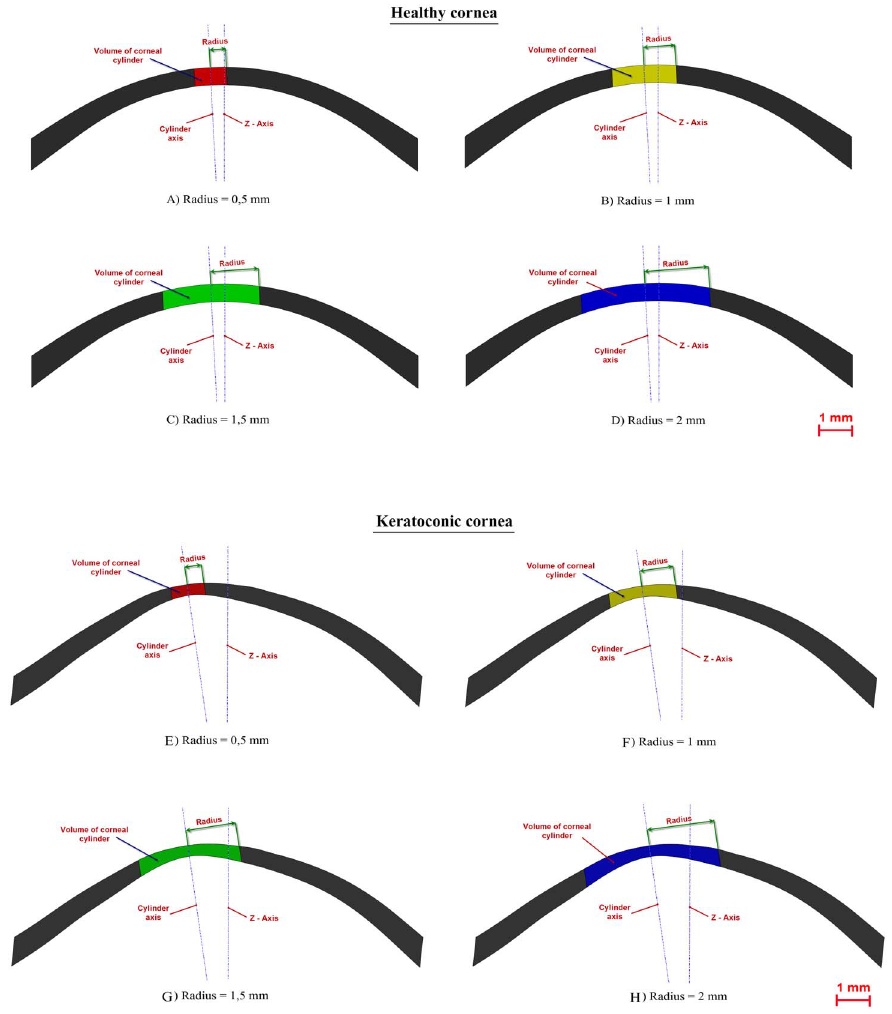
Figure 6. Schematic representation of the difference in the volume of corneal cylinder with radius 0.5, 1.0, 1.5 and 2.0 between a normal cornea (A–D) and a cornea with keratoconus (E–H). doi:10.1371/journal.pone.0110249.g006 normal and keratoconus eyes, and there is no statistical difference in x, y and z, or in net deviation from the center of mass in x, y.